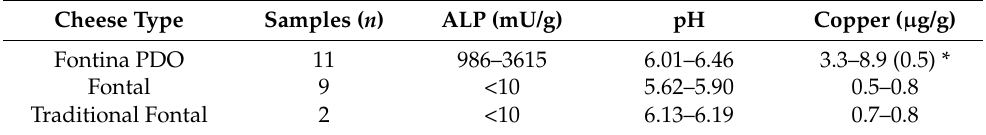
Table 1. Selected parameters (ranges of values) characterizing commercial samples of Fontina PDO, Fontal and traditional Fontal